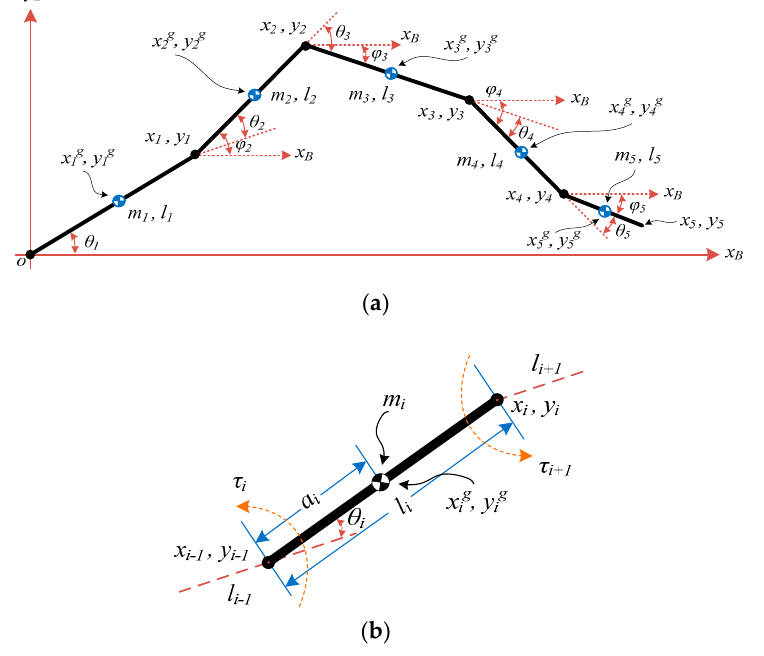
Figure 1. Kinematic scheme of the robotic fish: ( a ) Equivalent model; ( b ) Description of the one link.